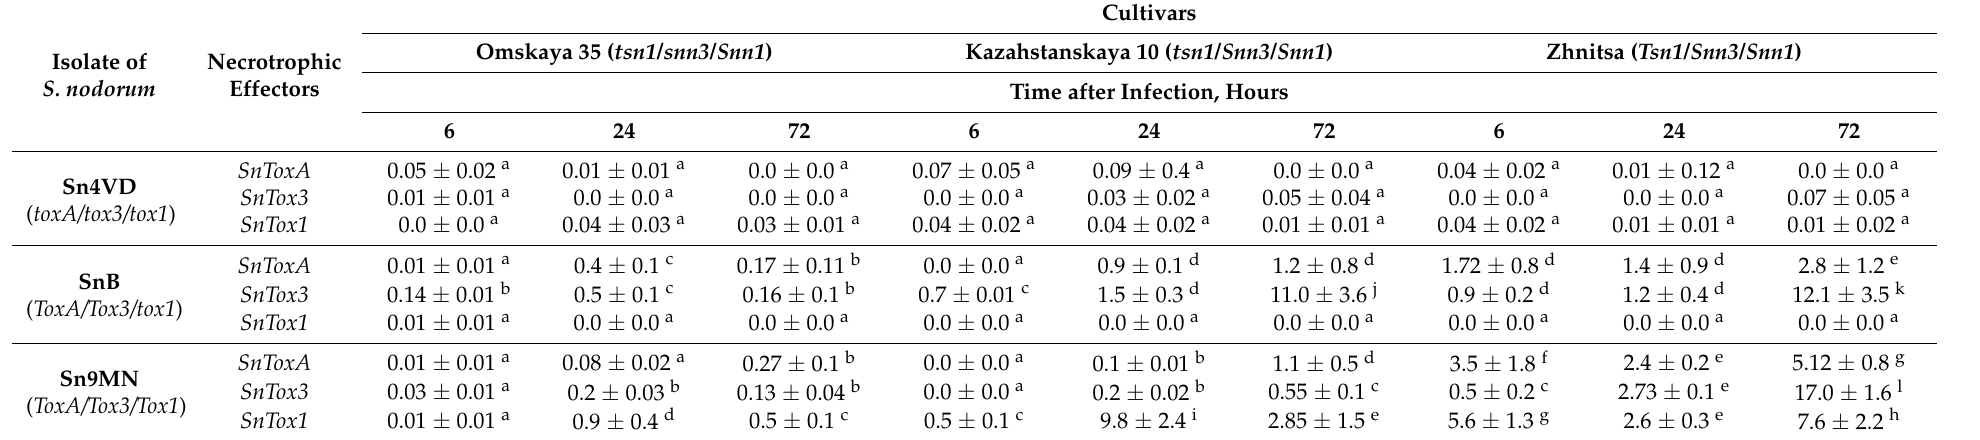
Table 1. Transcriptional activity of SnToxA , SnTox1 , and SnTox3 effector genes ( in planta ) in T. aestivum cultivars Zhnitsa, Kazakhstanskaya 10, Omskaya 35 with different allelic states of susceptibility genes inoculated with S. nodorum isolates SnB, Sn9MN, Sn4VD.